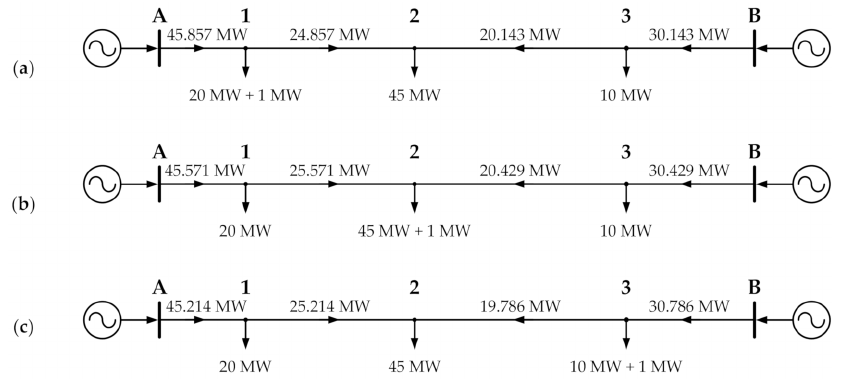
Figure 6. Natural active power flow after increasing the demand by 1 MW in bus: ( a ) 1; ( b ) 2; ( c ) 3. Table 6. Sensitivity factors of active power flow in branches with respect to the power consumed in